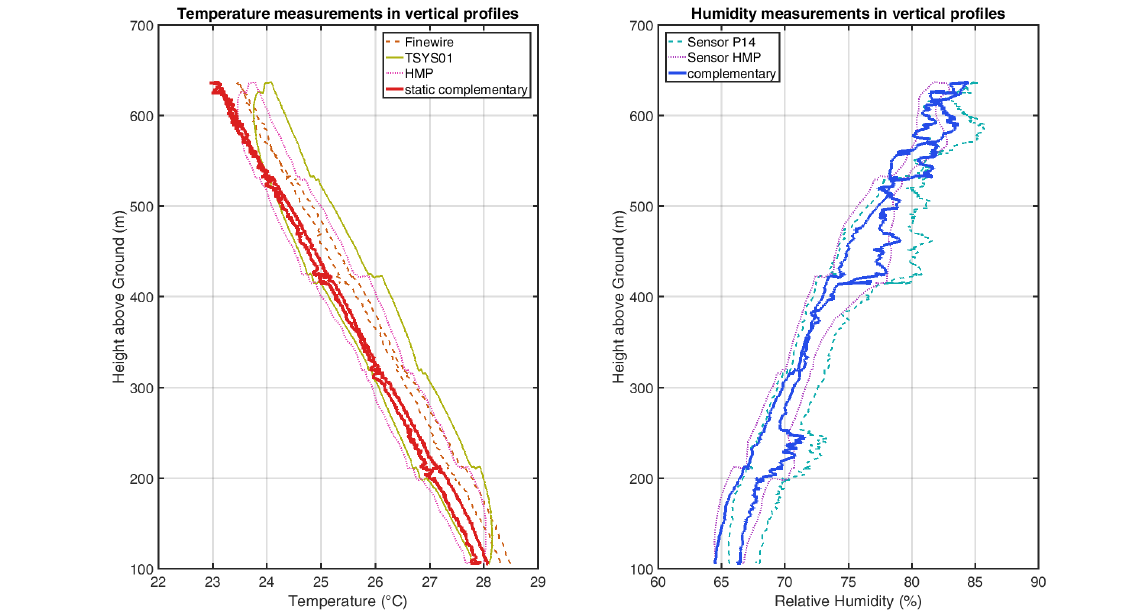
Figure 5. Vertical profiles of temperature ( left ) and humidity ( right ), measured during the project DACCIWA [27] on 15 July 2016 at 06:30 UTC in Savè (Collines,